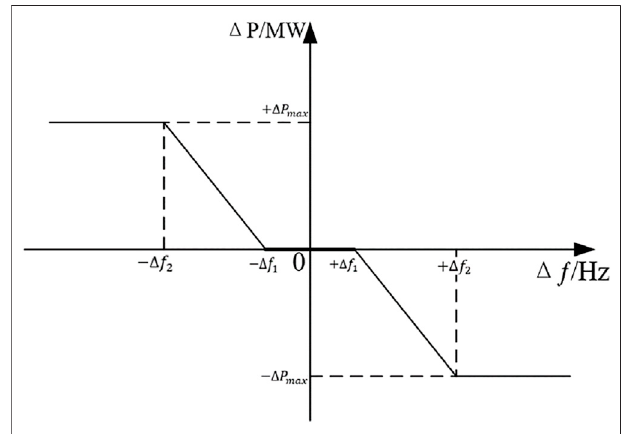
FIGURE 1 | Corresponding relationship between frequency deviation and load